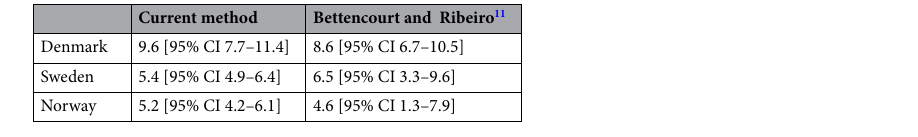
Table 2. Estimation of the basic reproduction number R 0 using our method and Bettencourt and Ribeiro 11